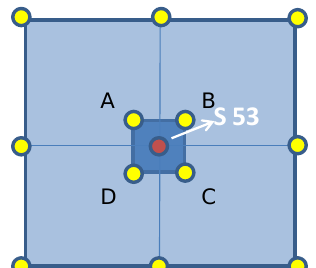
Figure 1. Sampling plan of the additional cores investigated around the core S53. The four additional cores are labeled with letters A-D.